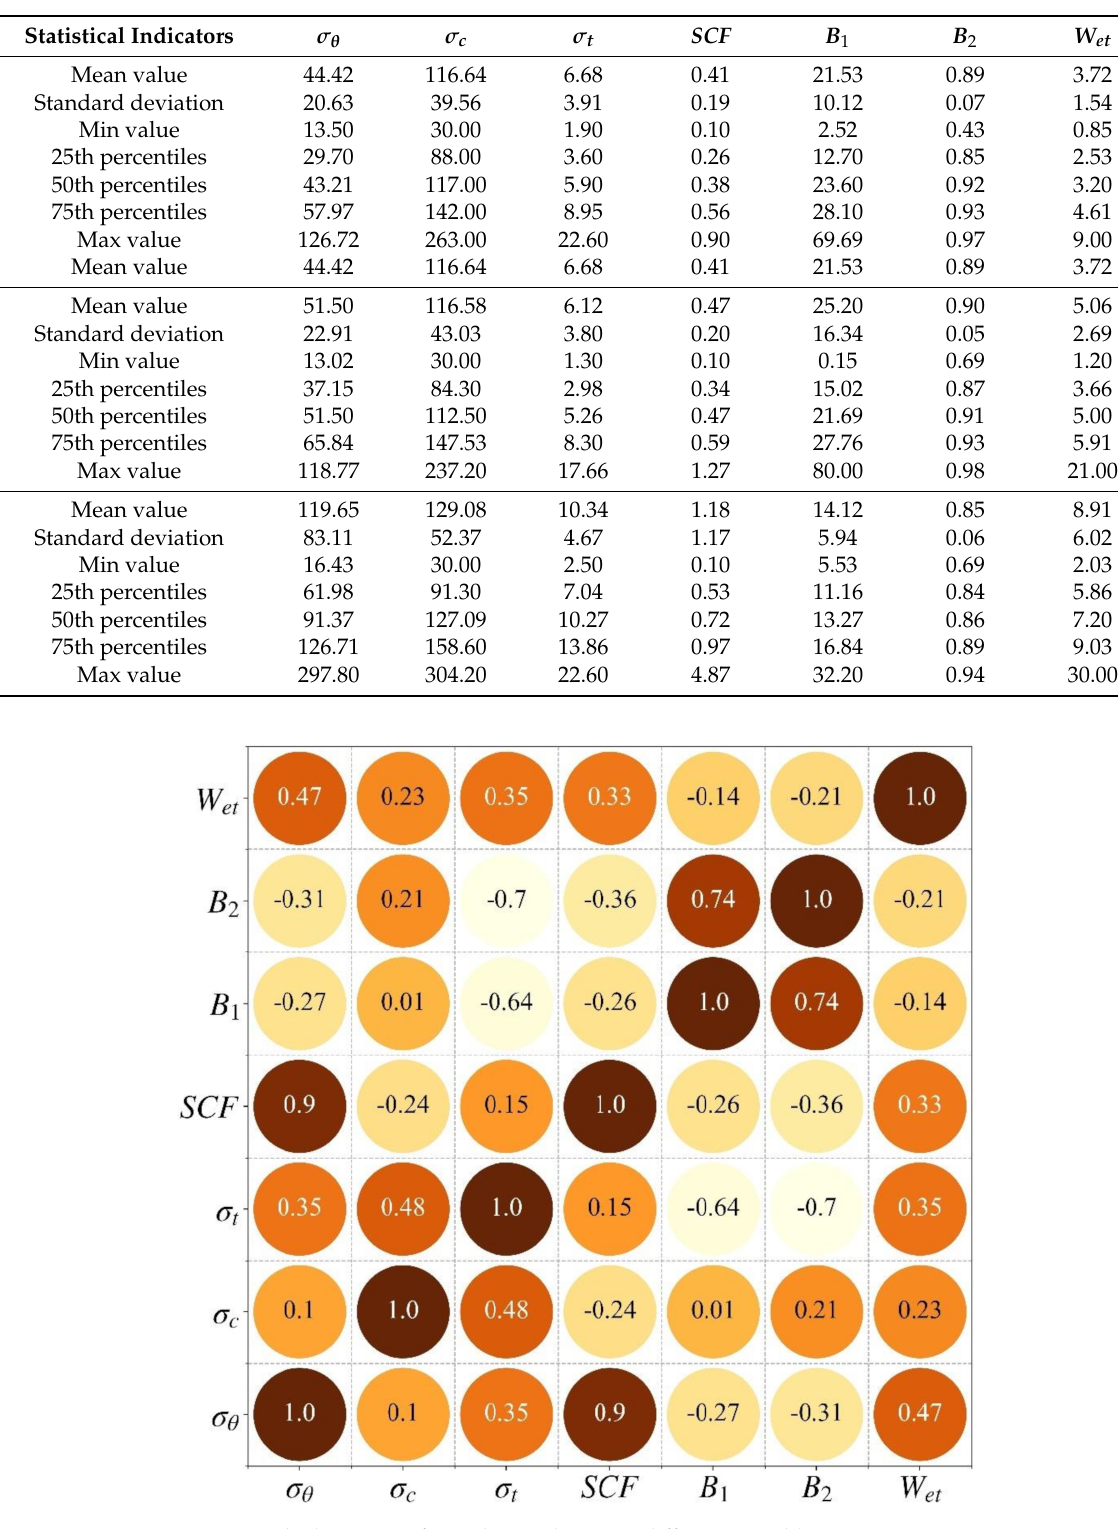
Figure 3. The heatmap of correlations between different